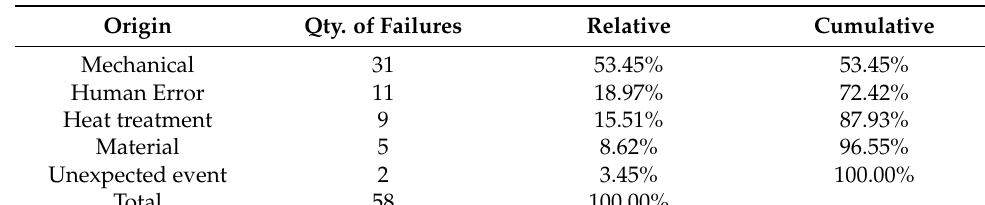
Table 6. Frequency of kinds of failures by origin.